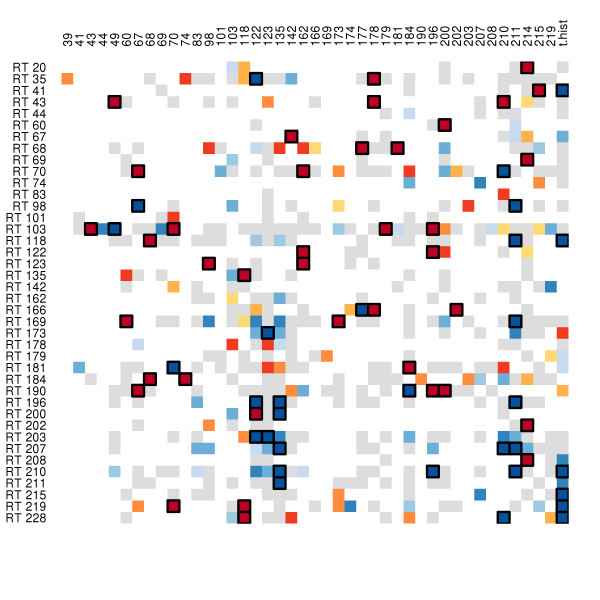
Adjacency matrix of pathways within commonly mutant locations. Columns are pre-existing mutations, rows are the outcome mutation. The matrix has been reduced to only include rows or columns with at least one detected effect. Colored cells are those which were suggested by SCAD. Grey cells had p > 0.05; the remaining cells are colored based on p-value, with darker colors indicating lower p-values. Red colors indicate a pre-existing mutation was associated with an increase in hazard, blue indicates a reduction. A box has been drawn around cells with p < 0.01.